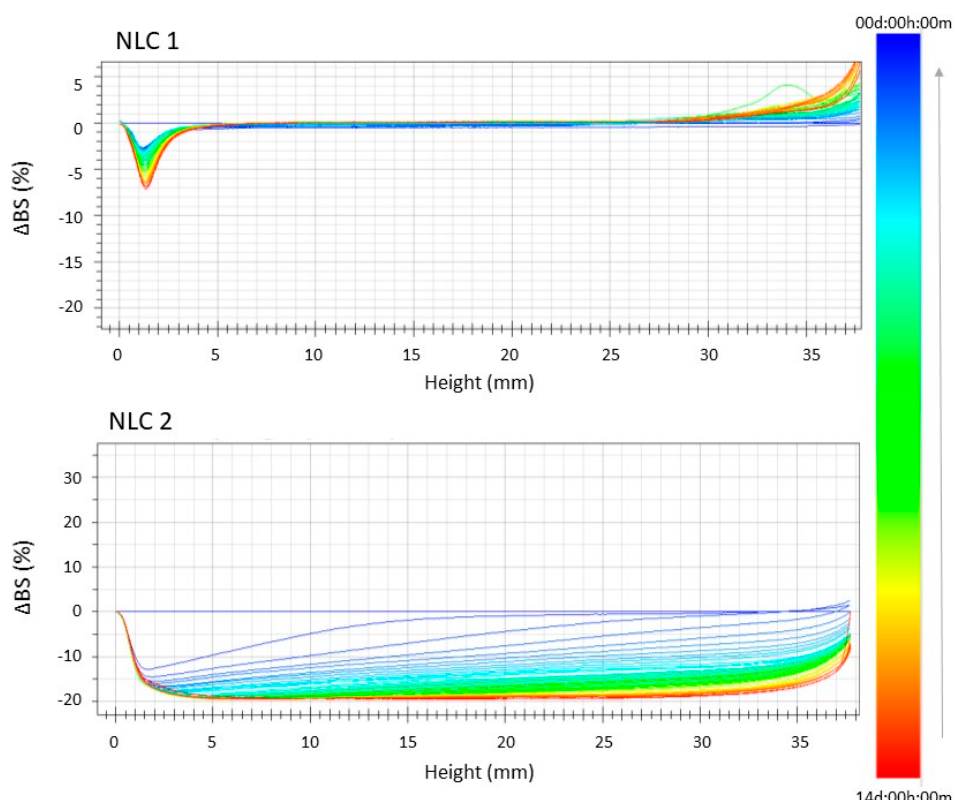
Figure 3. Backscattering profiles ( Δ BS) of NLC 1 and NLC 2 stored in Turbiscan® at 35.5 ± 1.0 °C. Data are represented as a function of time (0–14 days) of sample height (0–20 mm). The sense of analysis time is indicated by the arrow.